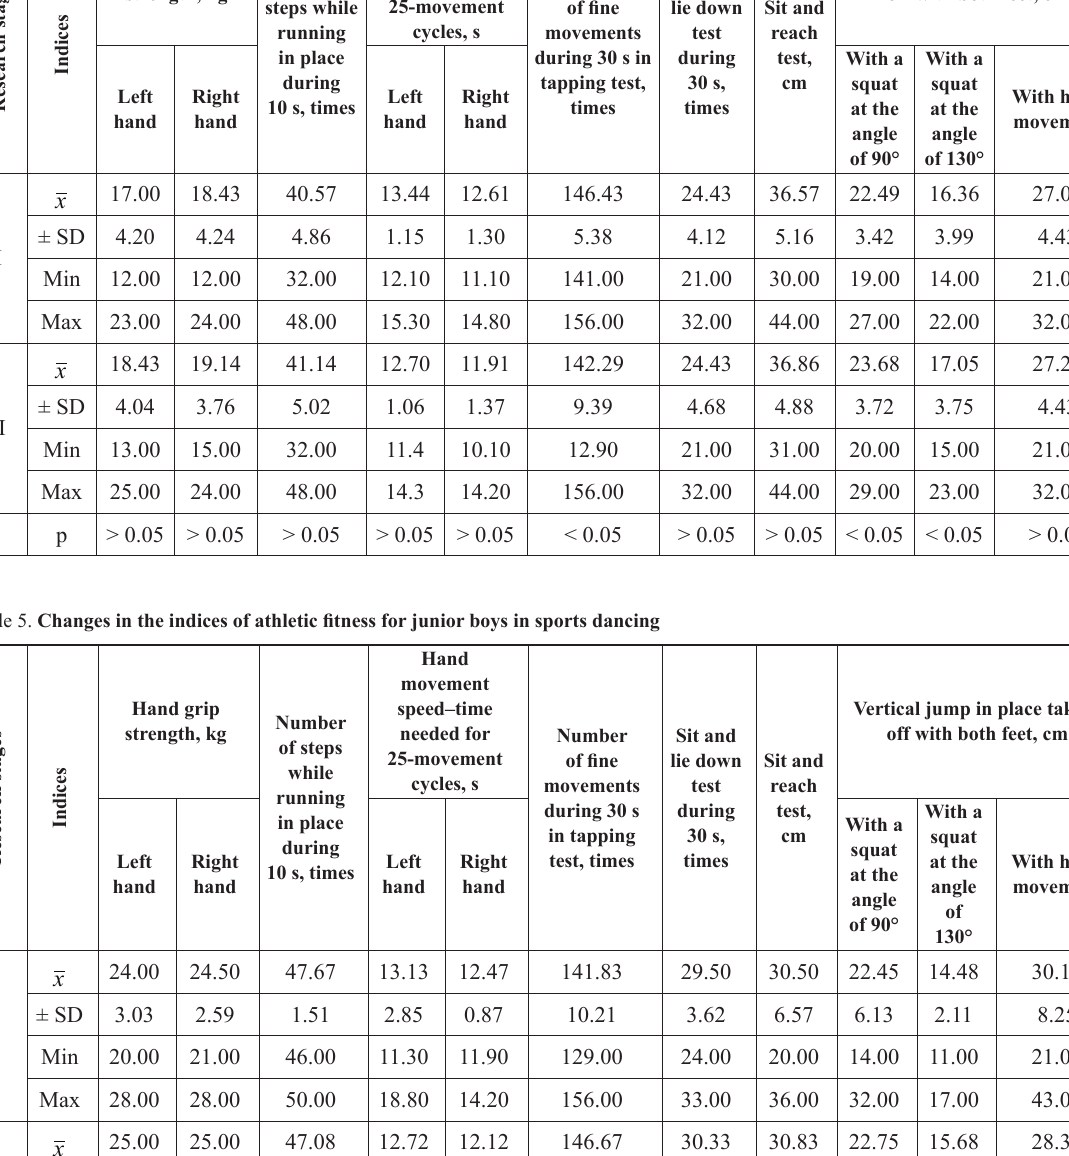
Table 4. Changes in the indices of athletic fitness for junior girls in sports dancing Hand grip Number of sI strength, kg ag e steps while s t ce running h rc nd i in place a during s e Right R e 10 s, times hand